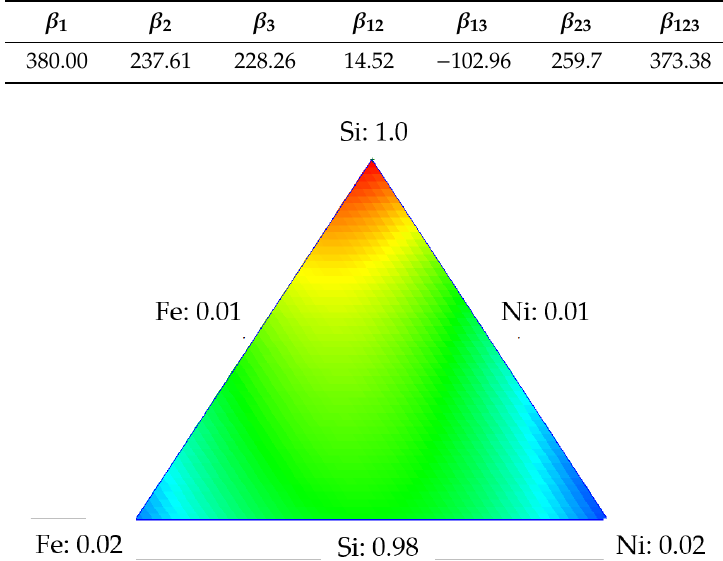
Table 2. Parameters of the surface area design for the Si-Fe-Ni series.